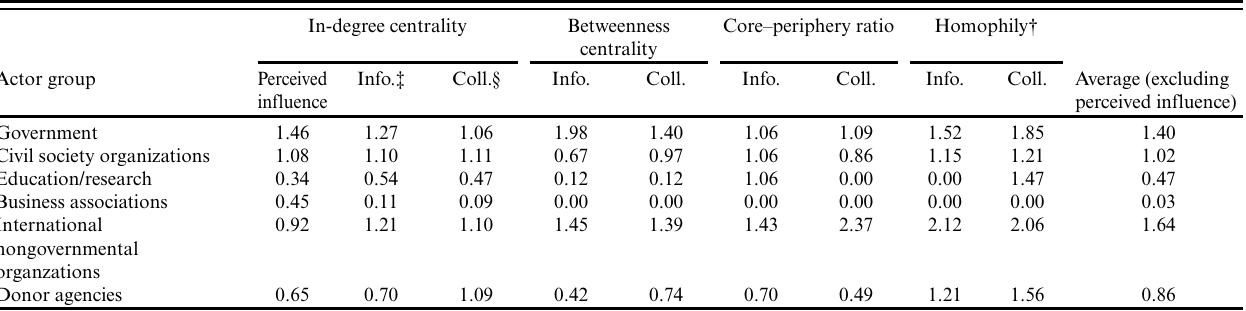
Table 6. Group averages for network measures as a proportion of the average for all actors for each network variable. Results indicate the relative overall importance (i.e., power) of each actor group in the REDD+ policy arena. In-degree centrality Betweenness Core–periphery ratio centrality Actor